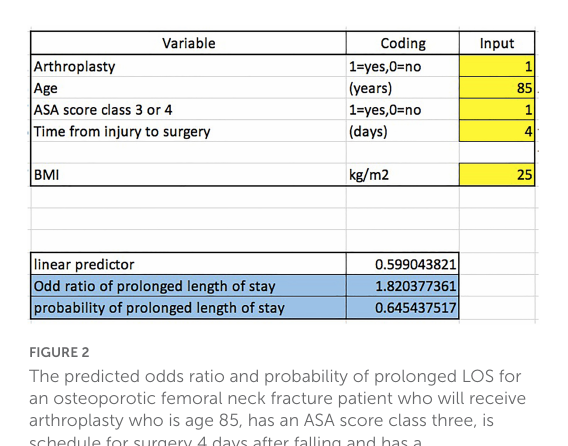
FIGURE2 The predicted odds ratio and probability of prolonged LOS for an osteoporotic femoral neck fracture patient who will receive arthroplasty who is age 85, has an ASA score class three, is schedule for surgery 4 days after falling and has a BMI = 25 kg/m 2